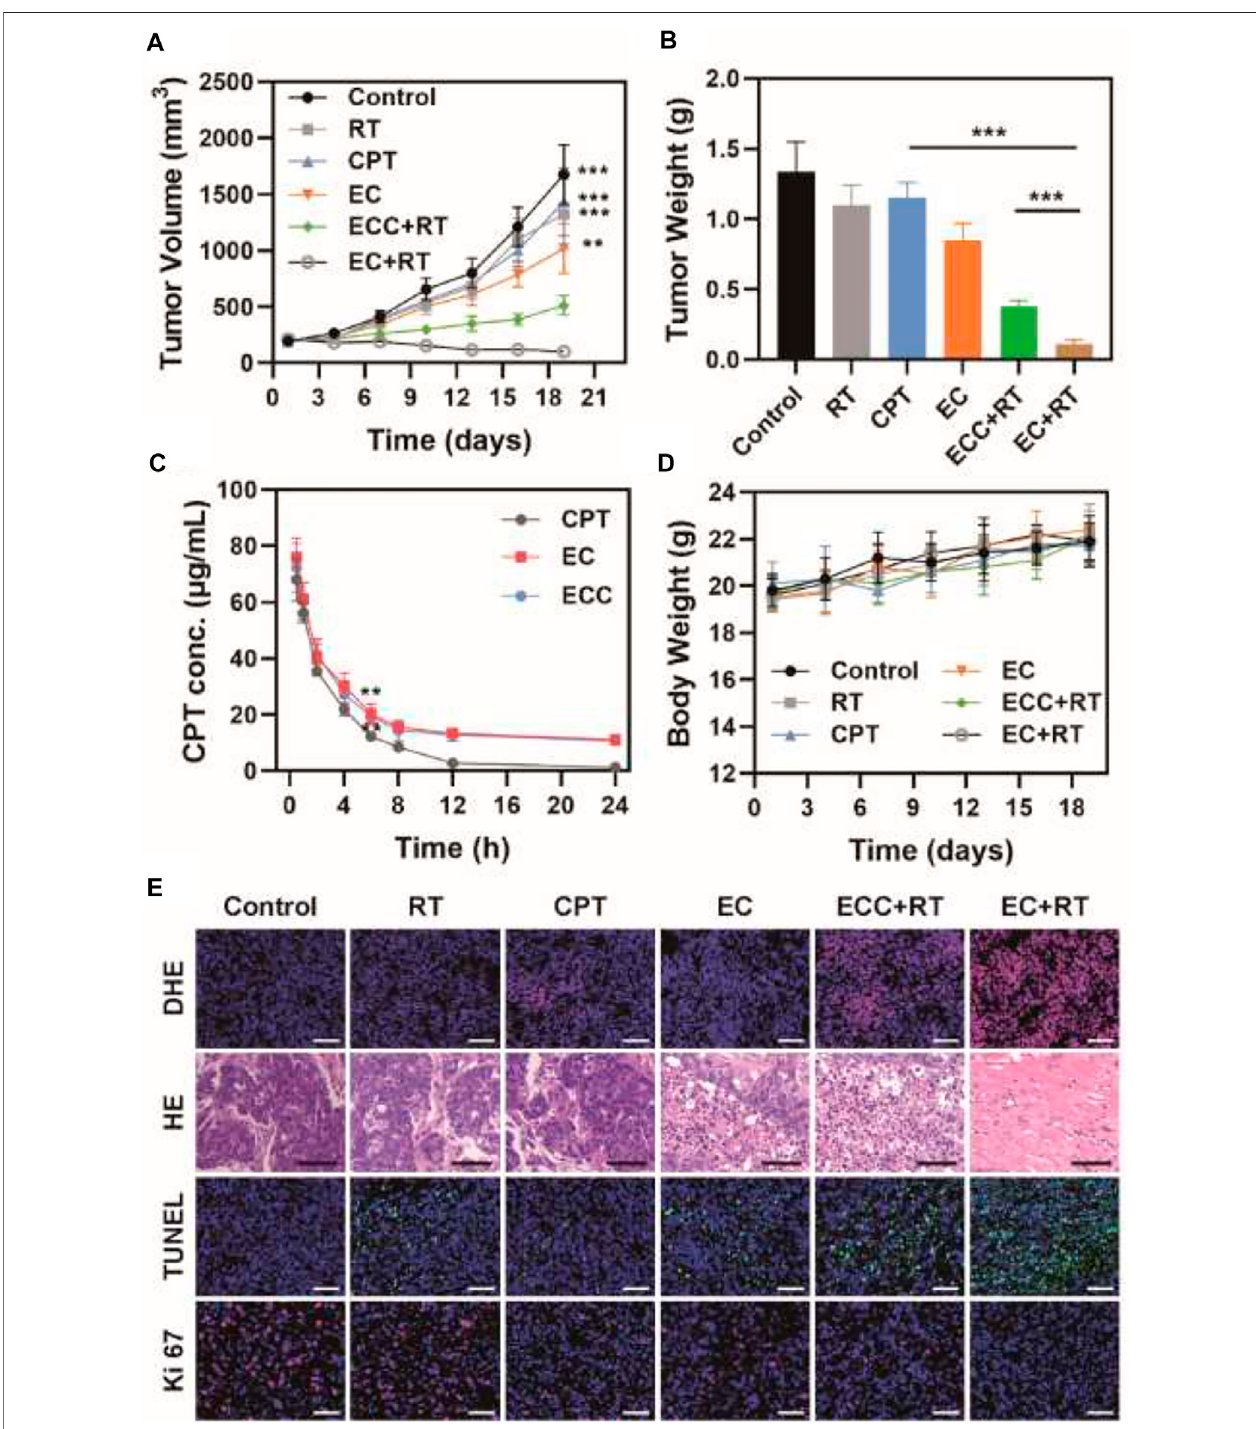
FIGURE4| Analysisofantitumoref fi cacy. (A) Tumorvolumesand (B) tumorweightvaluesformiceintheindicatedtreatmentgroups. (C) Pharmacokineticscurves for mice injected with CPT, EC, and ECC. (D) Changes in murine body weight over the study period. (E) DHE, H&E, TUNEL, and Ki 67 staining were conducted after treatment in the indicated groups (Scale bar: 100 μ m). * p < 0.05, ** p < 0.01, *** p < 0.005; Student ’ s t-test.